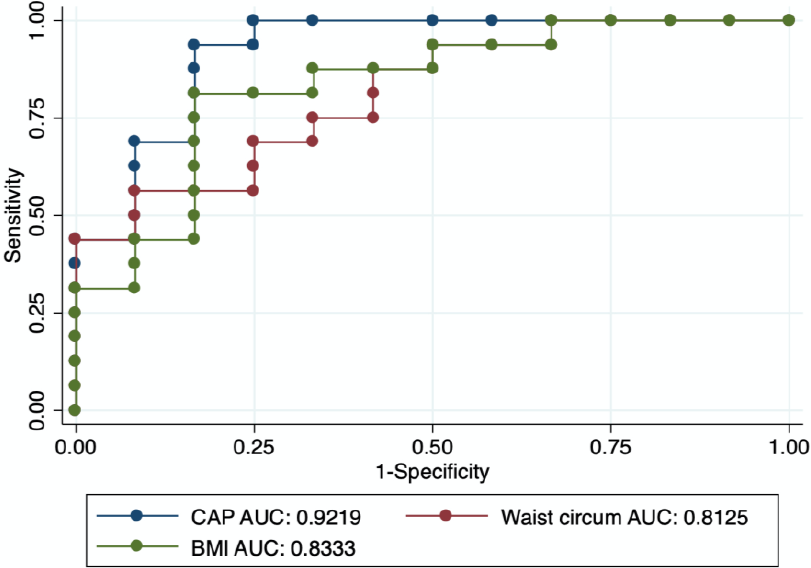
Figure 2. Area under the curve of CAP, BMI and waist circumference for prediction of excess VAT. Due to the relative small sample size, we did not run a direct comparison among CAP, BMI and waist circumference. The optimized cut-off of CAP to diagnose excess VAT was 266 dB/m, able to correctly classify 86.7% of patients, with a sensitivity of 88.3% and a specificity of 84.6%, LR + 5.74, LR − 0.14.